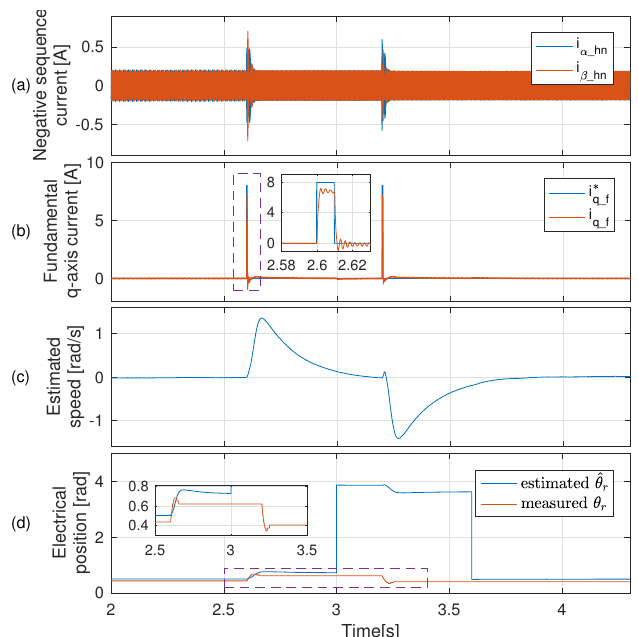
Figure 13. Initial rotor position estimation by the HFI method using current-observer-based current filter with no